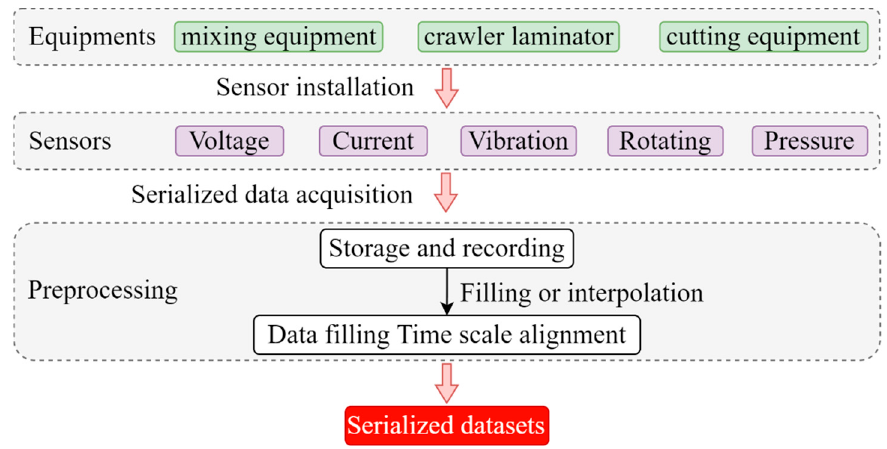
Figure 5. Acquisition and preprocessing of data fill and timing alignment.